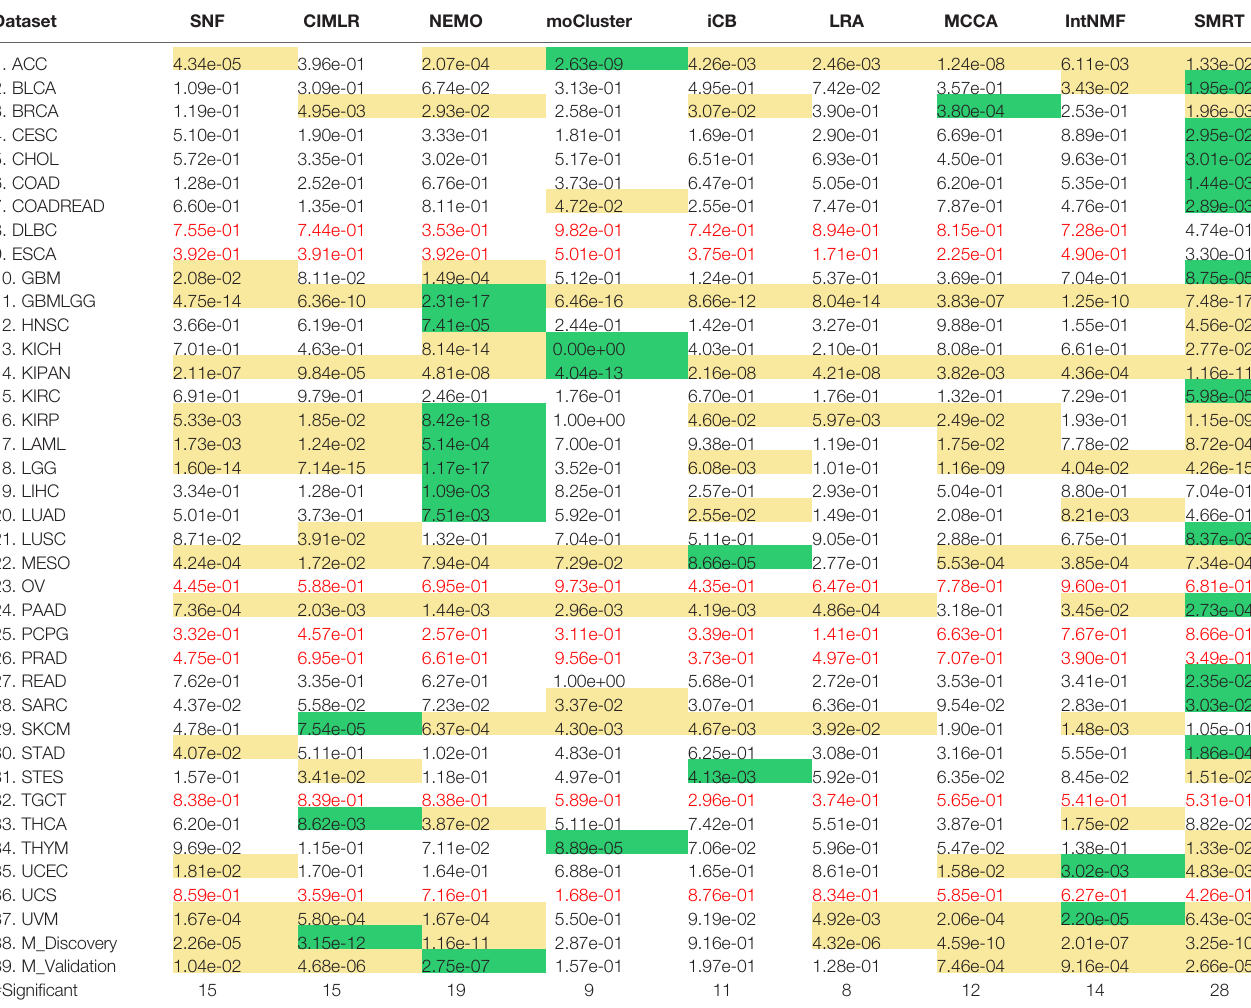
TABLE 1 | Cox p-values of subtypes discovered by SNF, CIMLR, NEMO, moCluster, iClusterBayes (iCB), LRACluster (LRA), MCCA, IntNMF, and SMRT for 37 TCGA datasets and two METABRIC breast cancer datasets (M_Discovery and M_Validation).